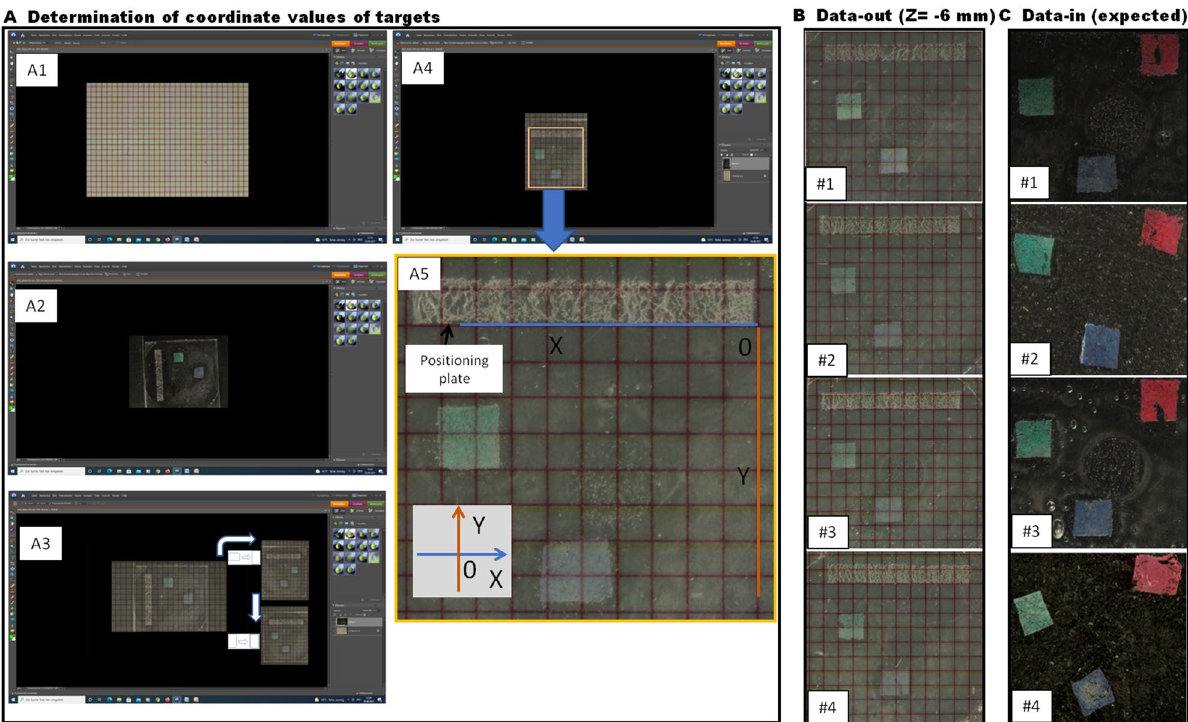
Figure 2. Localization of targets in data-out three-targeted models and the sections cut in paired data-in models. Secondary to serial sections cut in the data-out models, the coordinate values of target positions (green and blue) are determined in reference to red grid squares and a positioning plate ( A ). ( B ). Representative sections cut in the distal part (Z = − 6 mm) of the three-targeted data-out models (N = 4) display